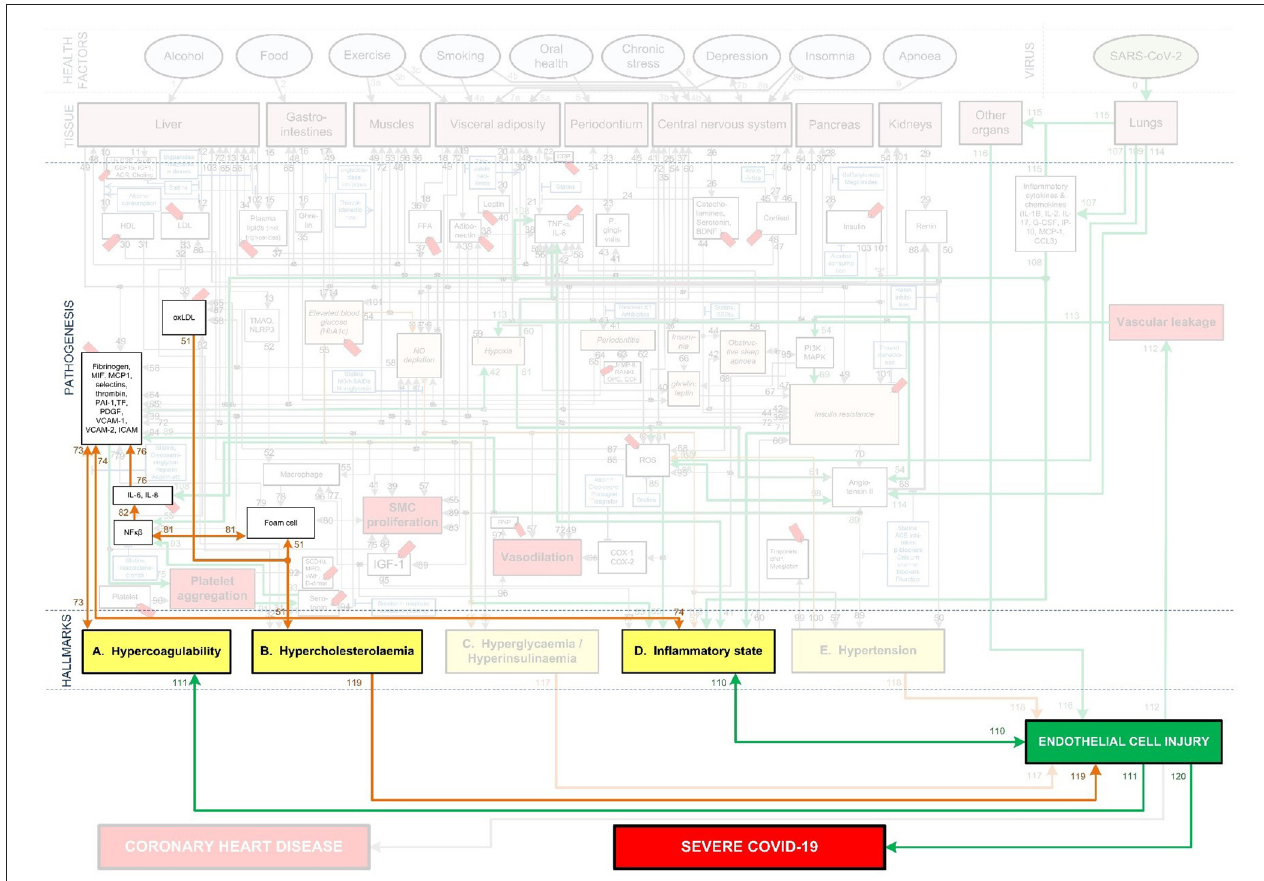
FIGURE 8 | CHD related aggravation of severe Covid-19 in patients with high